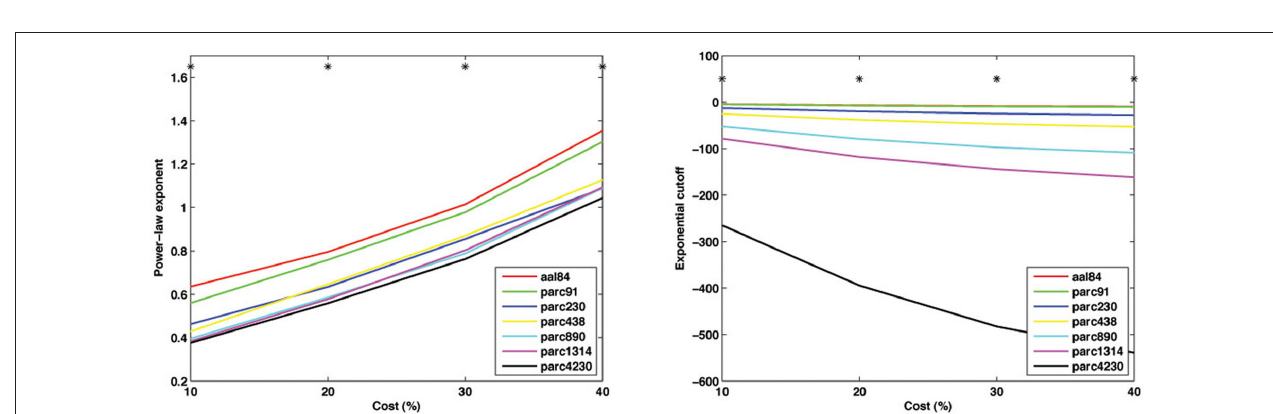
FIguRe 9 | Log–log nodal rank-degree plots for each parcellation scale at costs of 10, 20, 30, and 40%.